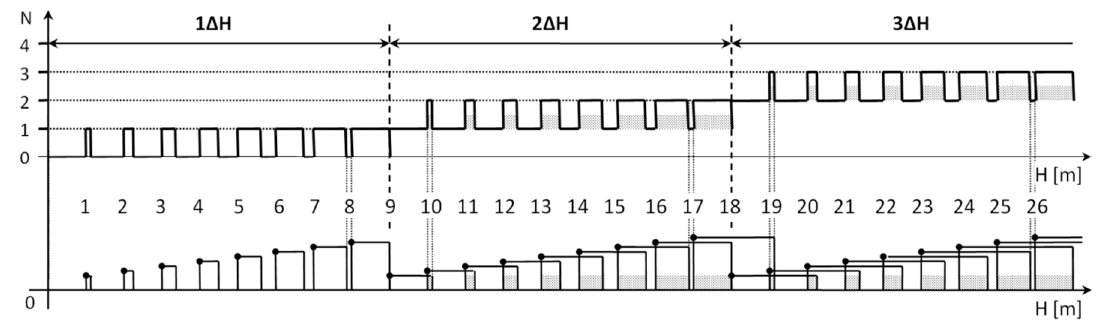
Figure 3. A flow chart of the formation of permanent and non-permanent pulses.